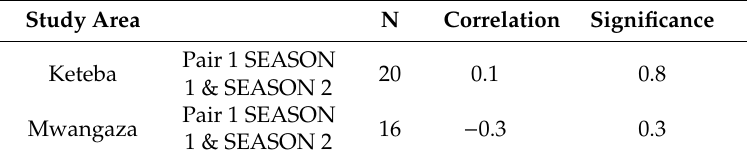
Table A5. Sample Correlations (Kaptumo division).